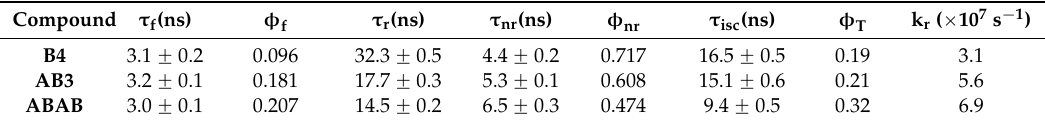
Table 1. Photophysical parameters of the studied ZnPc compounds dissolved in chloroform. Fluorescence lifetime ( τ f ), fluorescence quantum yield ( φ f ), radiative ( τ r ), non-radiative lifetime ( τ nr ), non-radiative ( φ nr ) quantum yield, intersystem crossing time ( τ isc ), triplet quantum yield ( φ T ) and radiative rate (k r ).